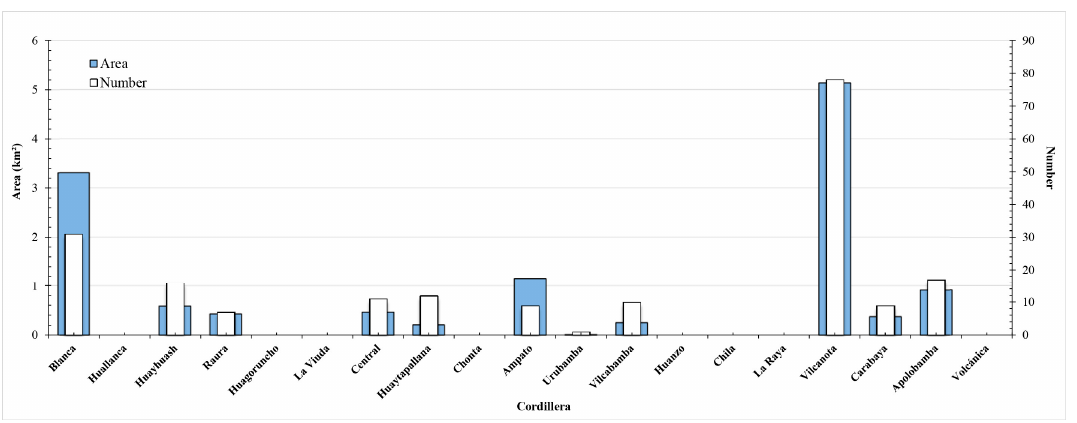
Figure 11. Areas and numbers of possible future lakes in the Cordilleras of Peru. A number of mountain ranges were identified where no further lake formation appears likely because the glaciers there are located on steep slopes and have small areas.